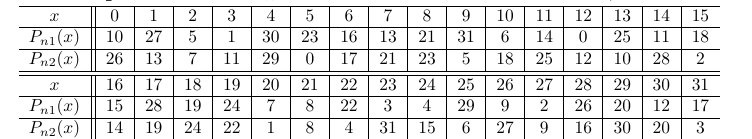
Table 4: Nibble permutation P nN for round function Branch N , where N ∈ { 1 , 2 }